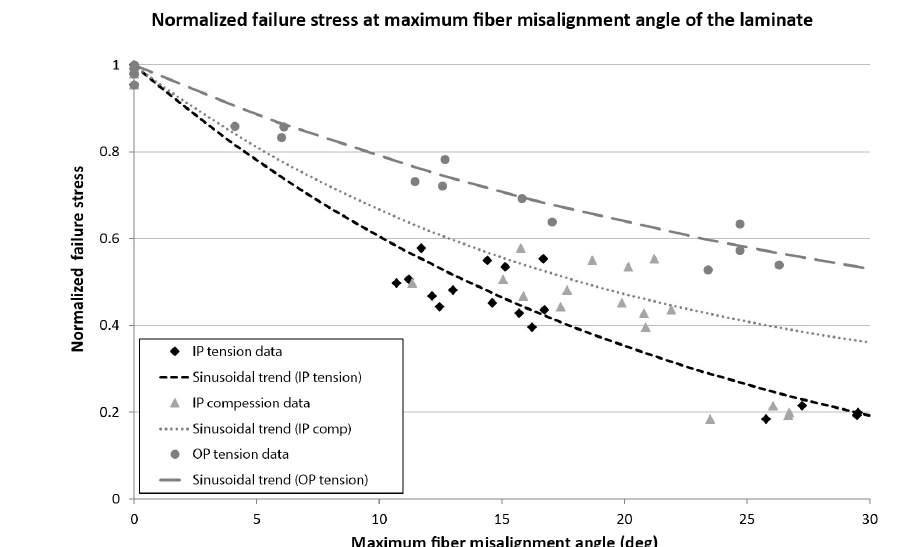
Figure 8. Peak stress of OP and IP waves at various fiber angles (left to right, respectively).